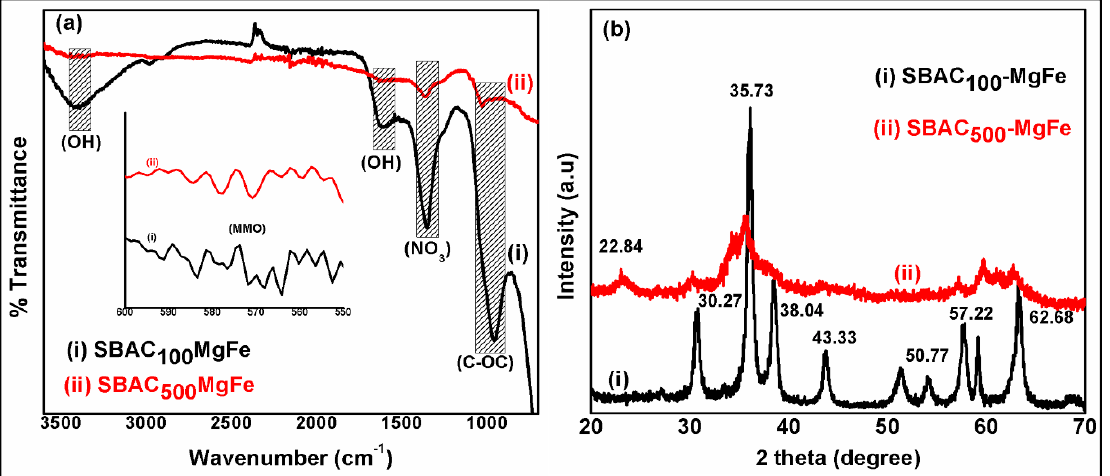
Figure 2. FT-IR spectra ( a ) and XRD patterns ( b ) of SBAC 100 MgFe and SBAC 500 MgFe composites.